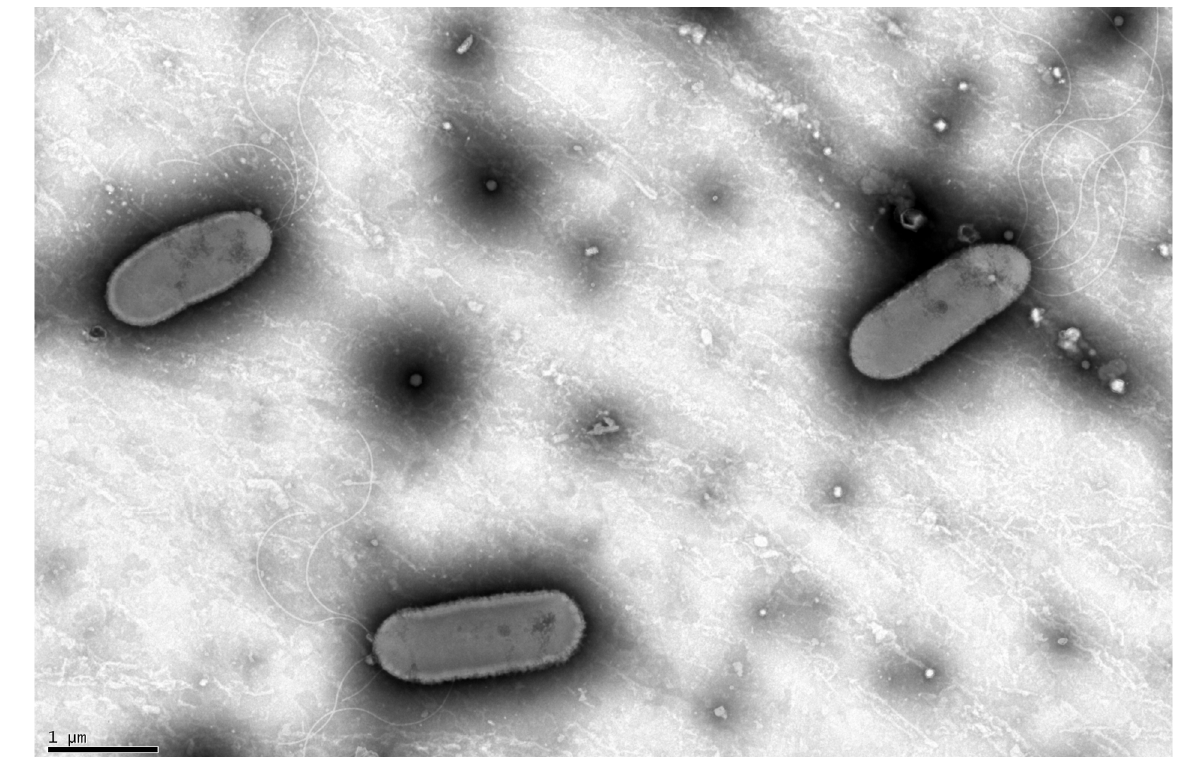
Figure 1. Transmission electron micrograph of EIF3 T . The micrograph depicts the rod ‐ shaped, flagellated morphotype of the Luteibacter EIF3 isolate. The image was taken using TEM after 24 h of cell growth at 30 °C in LB medium followed by negative staining.